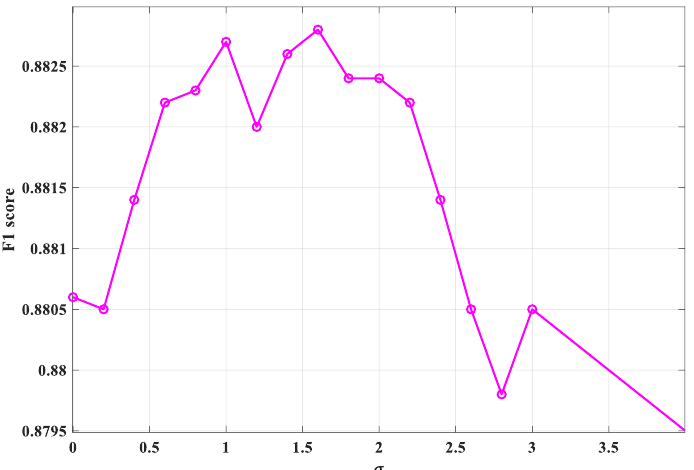
Figure 7. Effects of mesh smoothing on reliability of estimated curvature: ( a ) mesh partition; ( b ) no filtering; ( c ) σ = 0.3; ( d ) σ = 0.9; ( e ) σ = 1.6; ( f ) σ = 2.0; and ( g ) σ = 4.0.